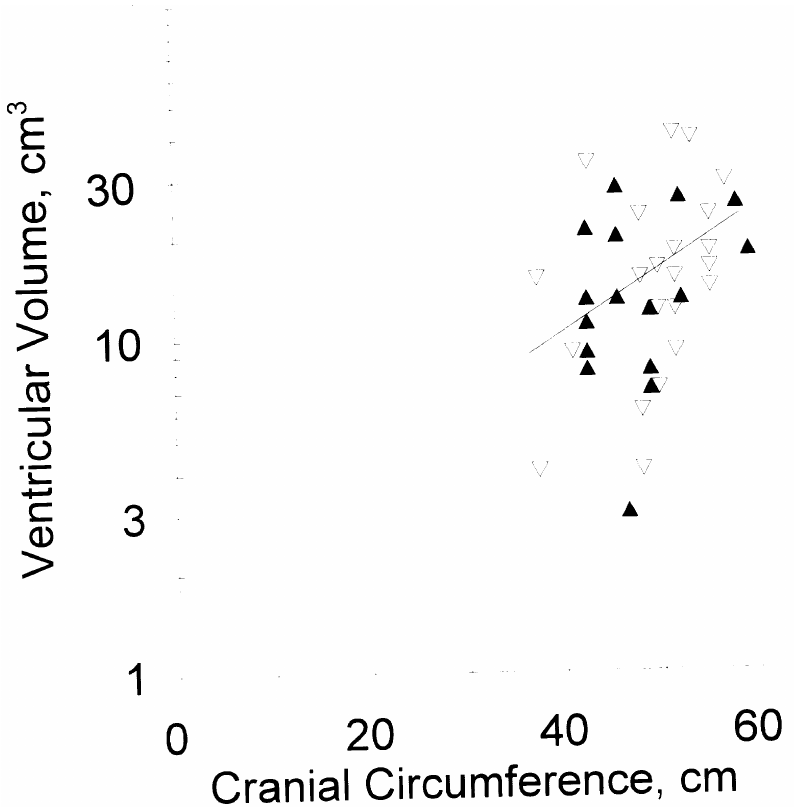
Fig. 5. The relation between the volume of the lateral plus third ventricles (cm 3 ) and cranial circumference (cm). The ventricular volume is positively correlated to cranial circumference only in the control males. ( 4 ) GTS males, ( 8 ) control